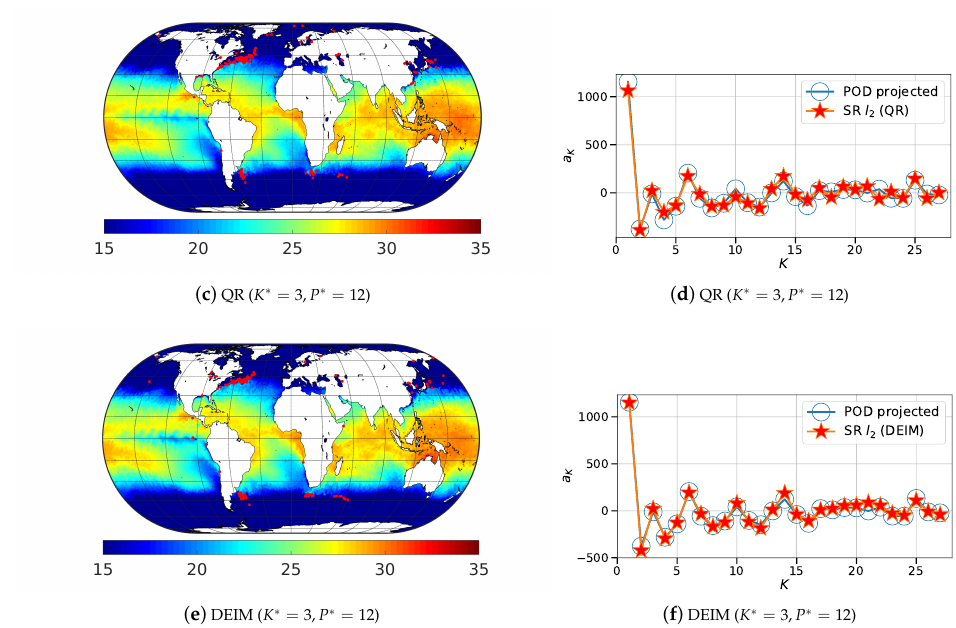
Figure 20. Comparison of the sparse reconstruction using Random, QR and DEIM sensor placement method on instantaneous snapshot for a highly oversampled case ( K ∗ = 3, P ∗ = 12). The left subfigures show the reconstructed solutions for different sensor placement methods namely, random placement ( a ), QR with column pivoting ( c ) and DEIM ( e ) whereas the corresponding reconstructed coefficients using POD-based SR are shown in subfigures ( b , d , f ). Red dots on the contour plots represent sensor